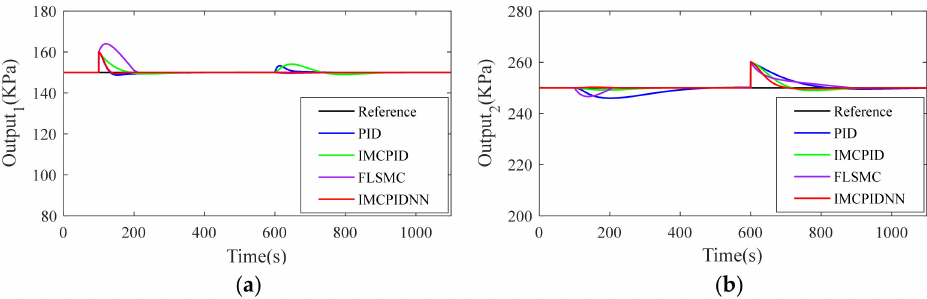
Figure 14. Comparison of closed-loop responses to external disturbance with +40% variation on time constant and gains: ( a ) Output1; ( b )